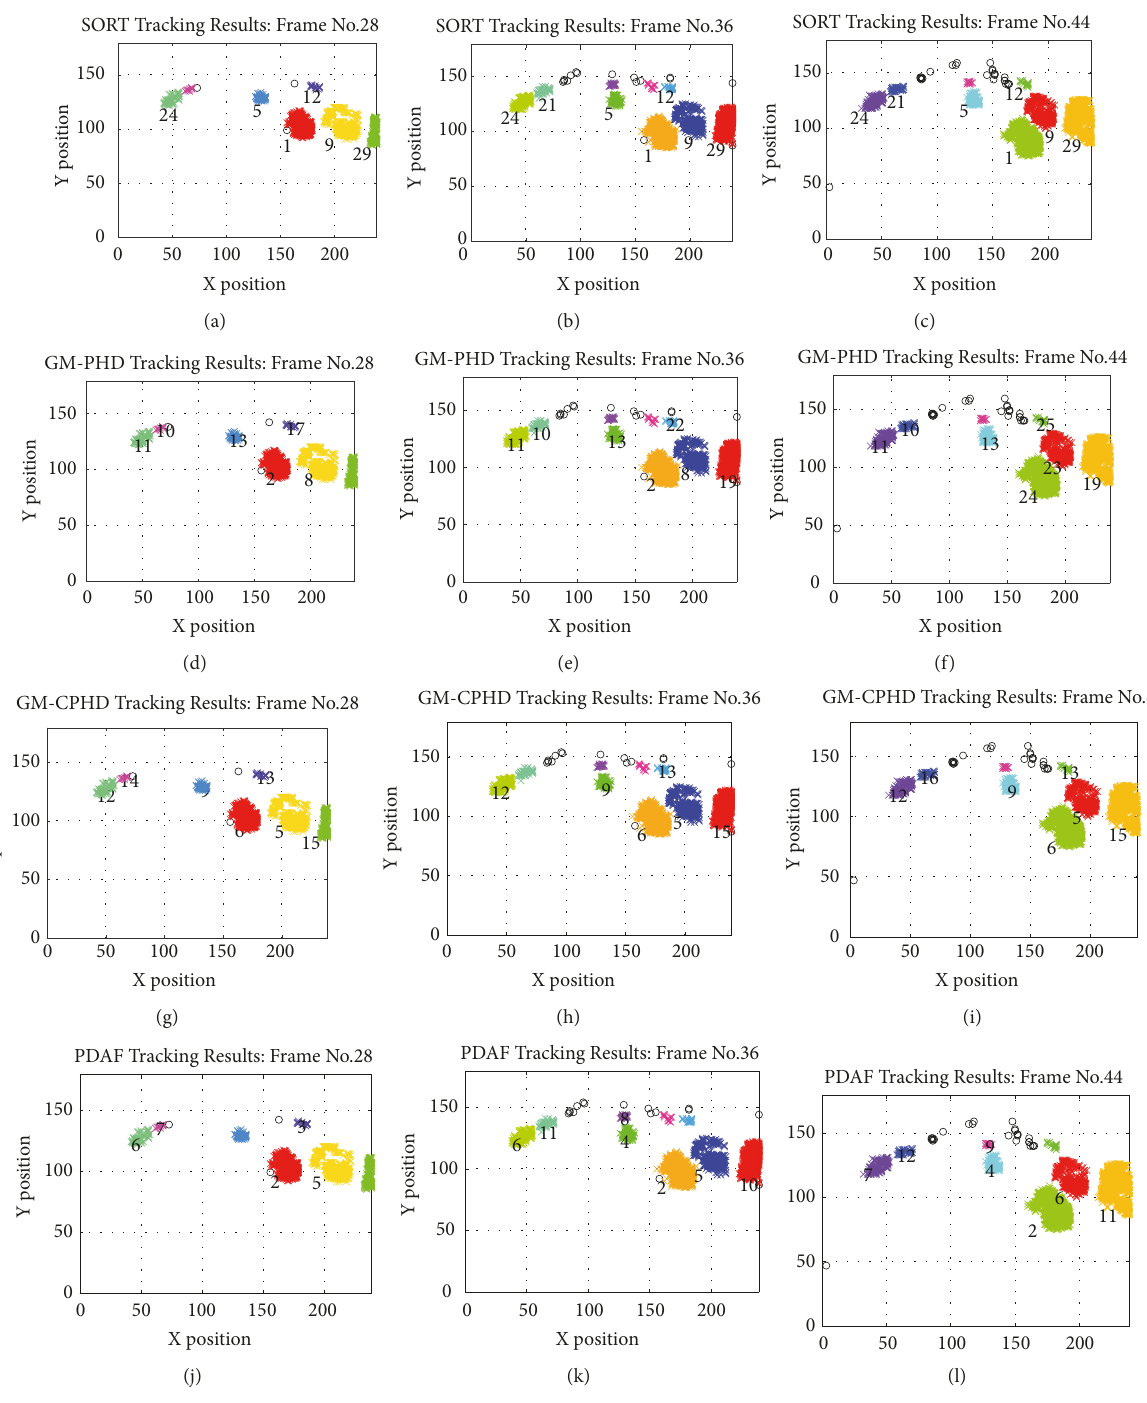
Figure 6: Tracking results from Frame 28 to Frame 44 for SORT, GM-PHD, GM-CPHD, and PDAF tracker. The numbers in black font near to cluster show the tracking ID (each object hypothesis is associated a tracker with a unique ID). The ID switching and lost IDs can also be witnessed from those sequences of input data (best viewed in